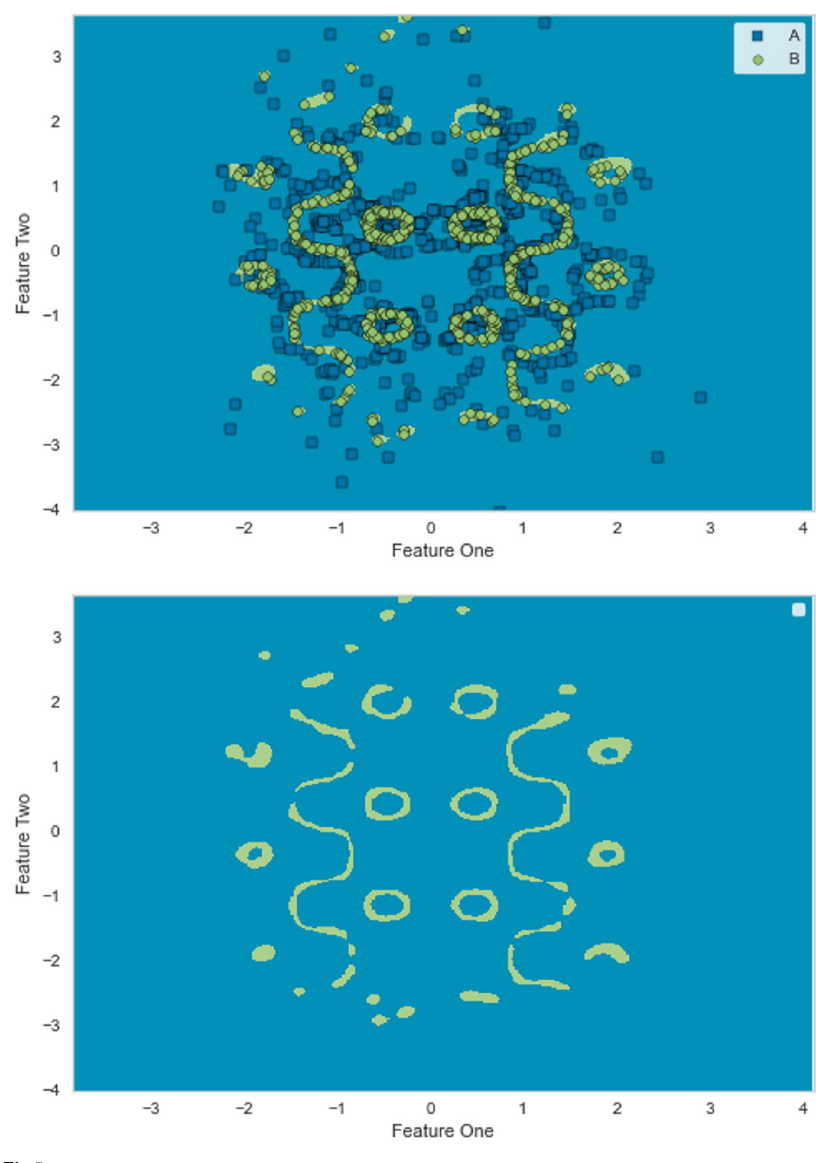
https://doi.org/10.1371/journal.pone.0285131.g005